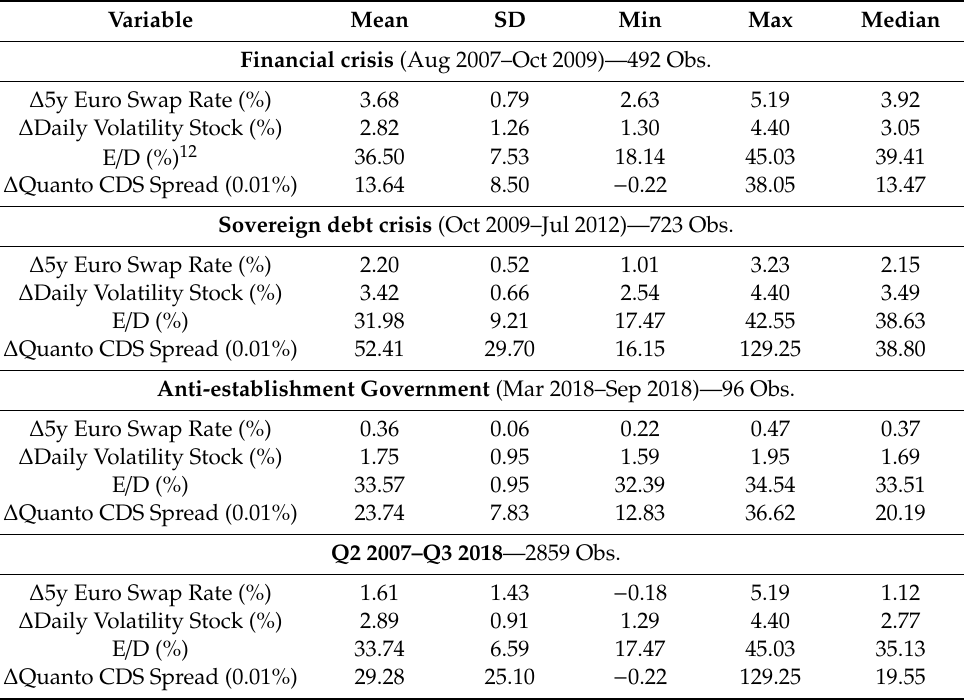
Table 2. Descriptive statistics of data—extended model